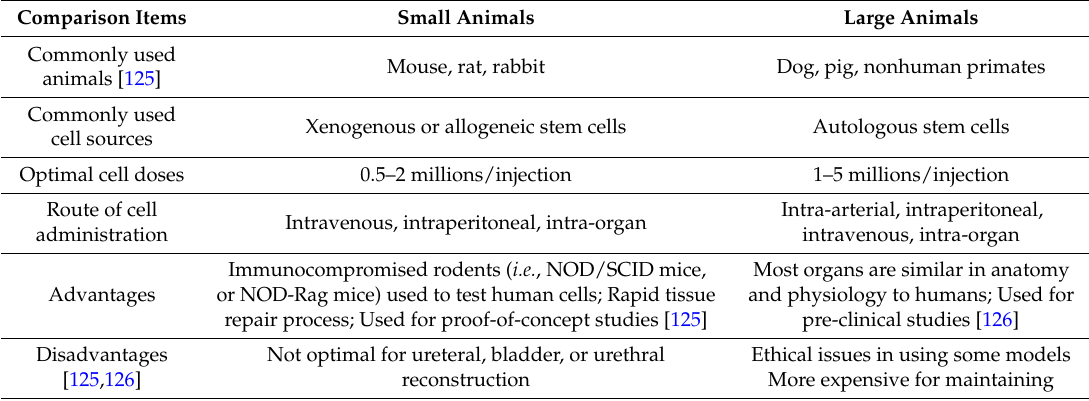
Table 4. Benefits and disadvantages of animal models for stem cell